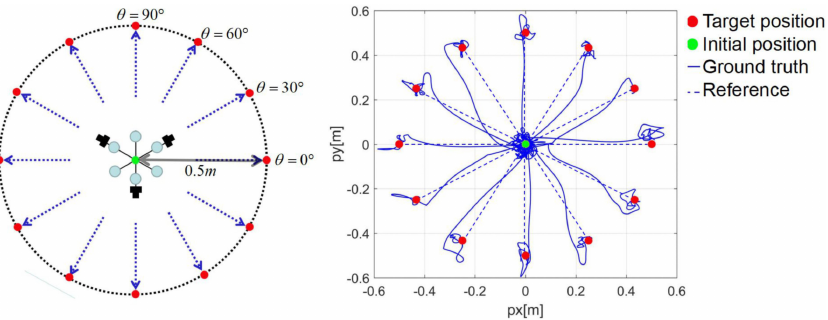
Figure 11. Experimental set up ( left ); and result ( right ) of translational movement in any